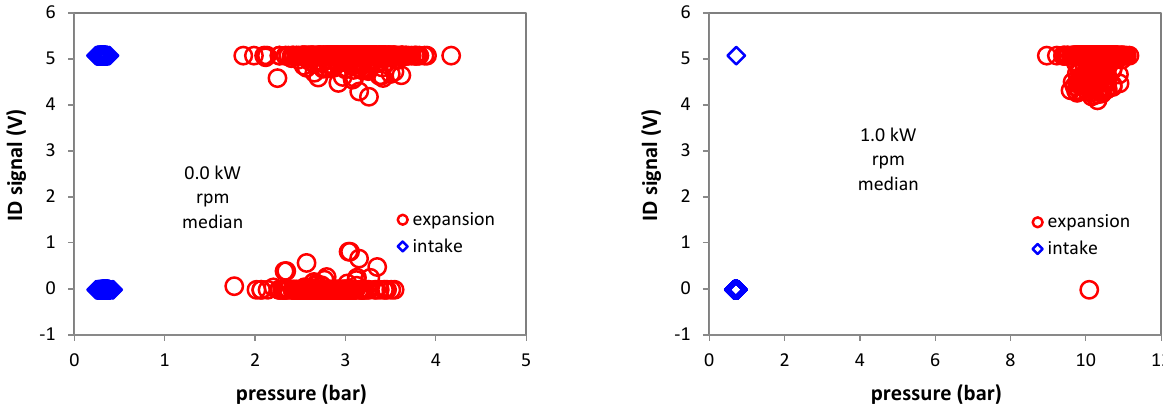
Figure 5. Distribution of the intake/expansion TDC ID signal and in–cylinder pressure for idle and full load conditions when employing the rpm method in median